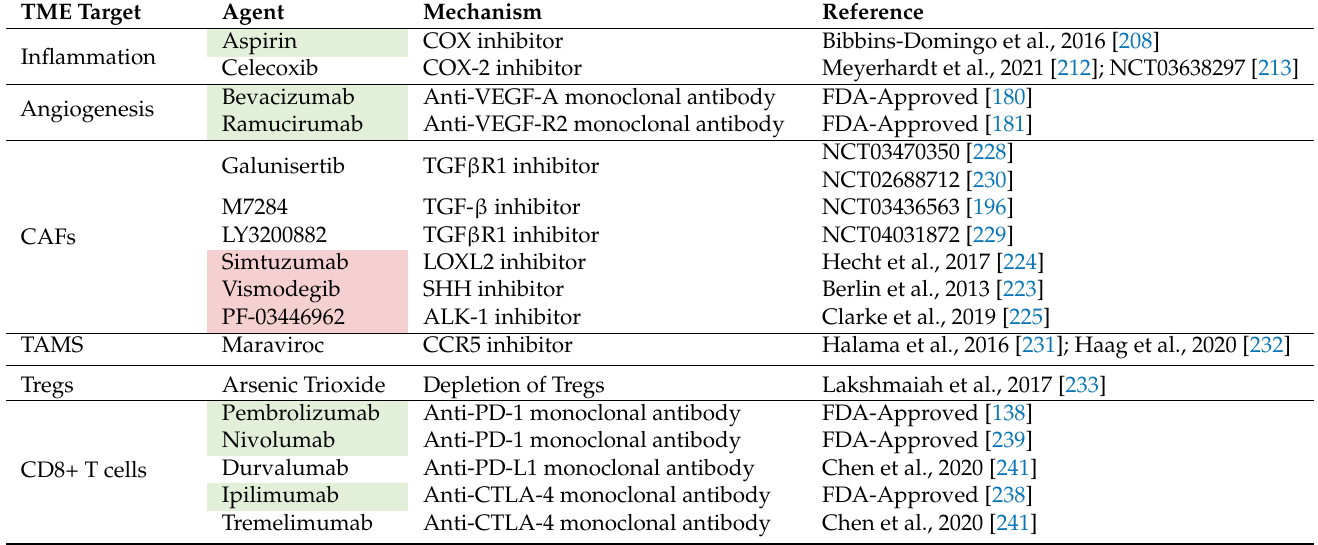
Table 2. TME-specific targeted therapies currently under recent investigation in clinical trials. Red highlights reflect trials with negative findings. Green highlights reflect agents which are FDA-approved or recommended by the United States Preventive Services Task Force